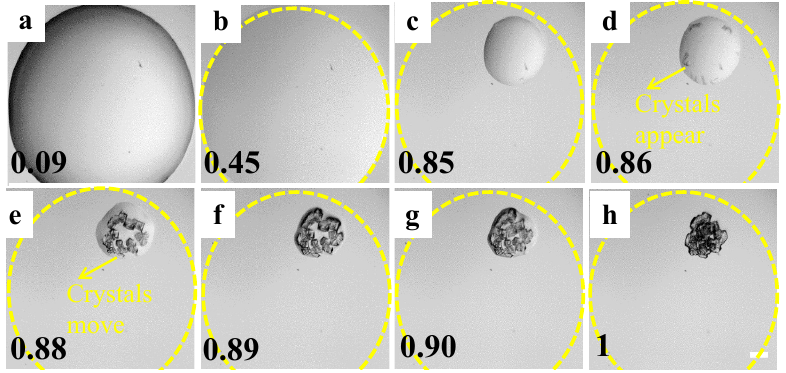
Figure 1. Drying evolution of the pattern formation in PBS droplet at the initial concentration ( φ PBS ) of 0.75 × is displayed in ( a – h ). The timestamps are shown with respect to the total drying time ( t d ) at the bottom left of each image. The yellow dashed circular line shows the drop lining as soon as the drop is deposited on the substrate. The white color in the right corner is a scale bar representing a length of 0.20